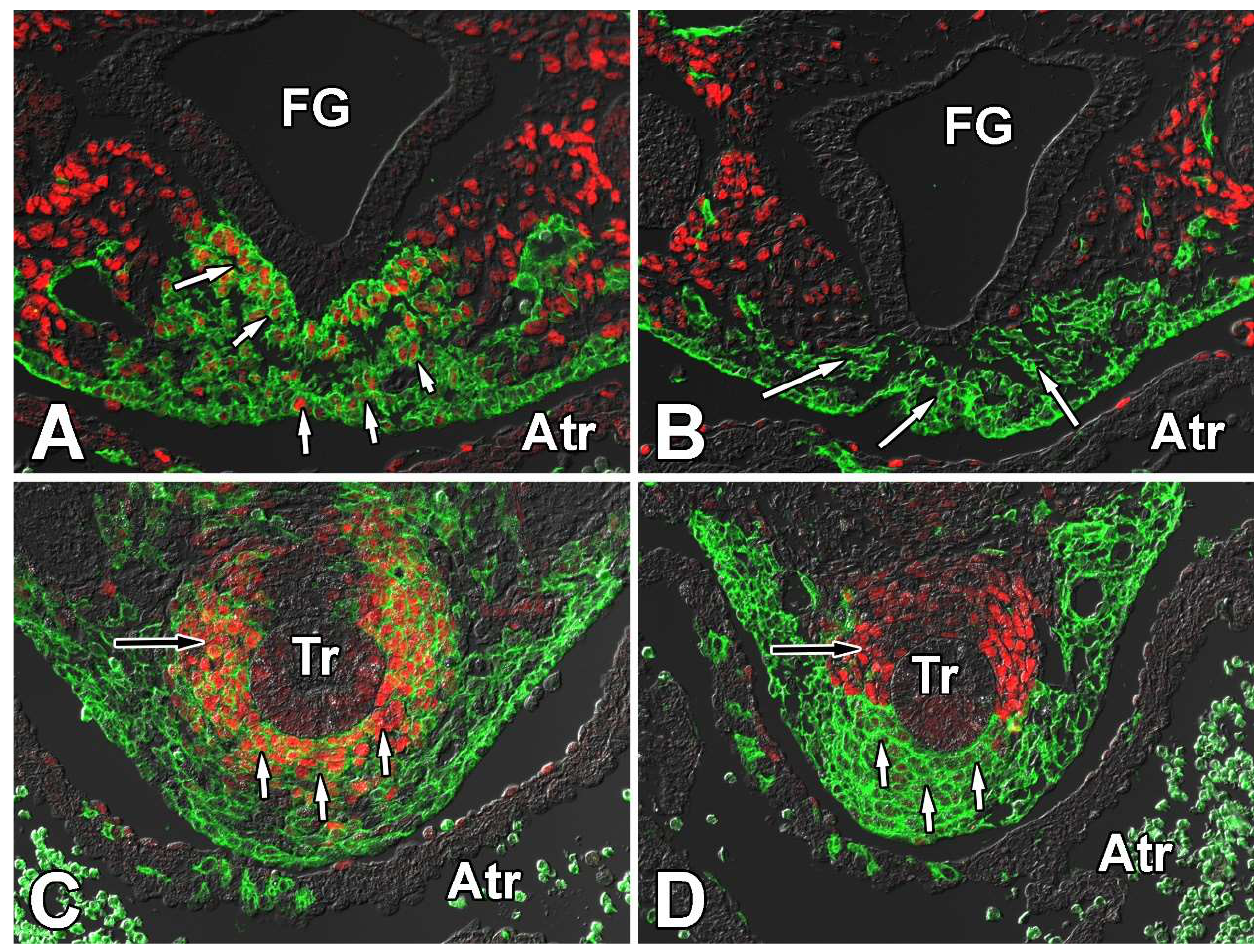
Figure 6. Deletion of Smoothened from the SHF results in downregulation of Sox9. Panels ( A , B ) show the expression of Sox9 (red) in relation to the SHF (green) at ED10.5 ventral to the developing foregut, while ( C , D ) show the situation in the same area at ED11.5. The sections in ( A , C ) are from SHFcre;R26mG control specimens showing the expression of Sox9 in a subset of the GFP-labeled SHF cells, whereas ( B , D ) are sections from SHFcre;Smofl/fl;R26mG embryos demonstrating the fact that deletion of Smo from the SHF has resulted in loss of Sox9 from these cells as well. Atr = atrium, FG = foregut, Tr = trachea.